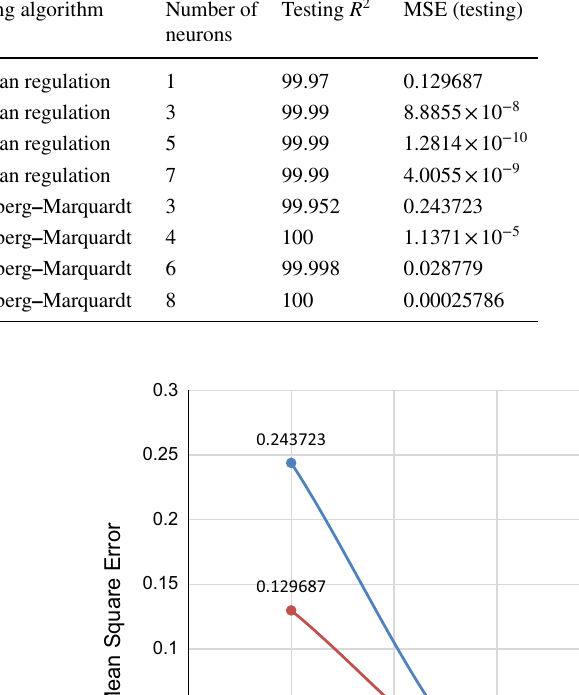
Table 1 Performance comparison of two different training techniques used of membrane scaling and fouling prediction Training algorithm